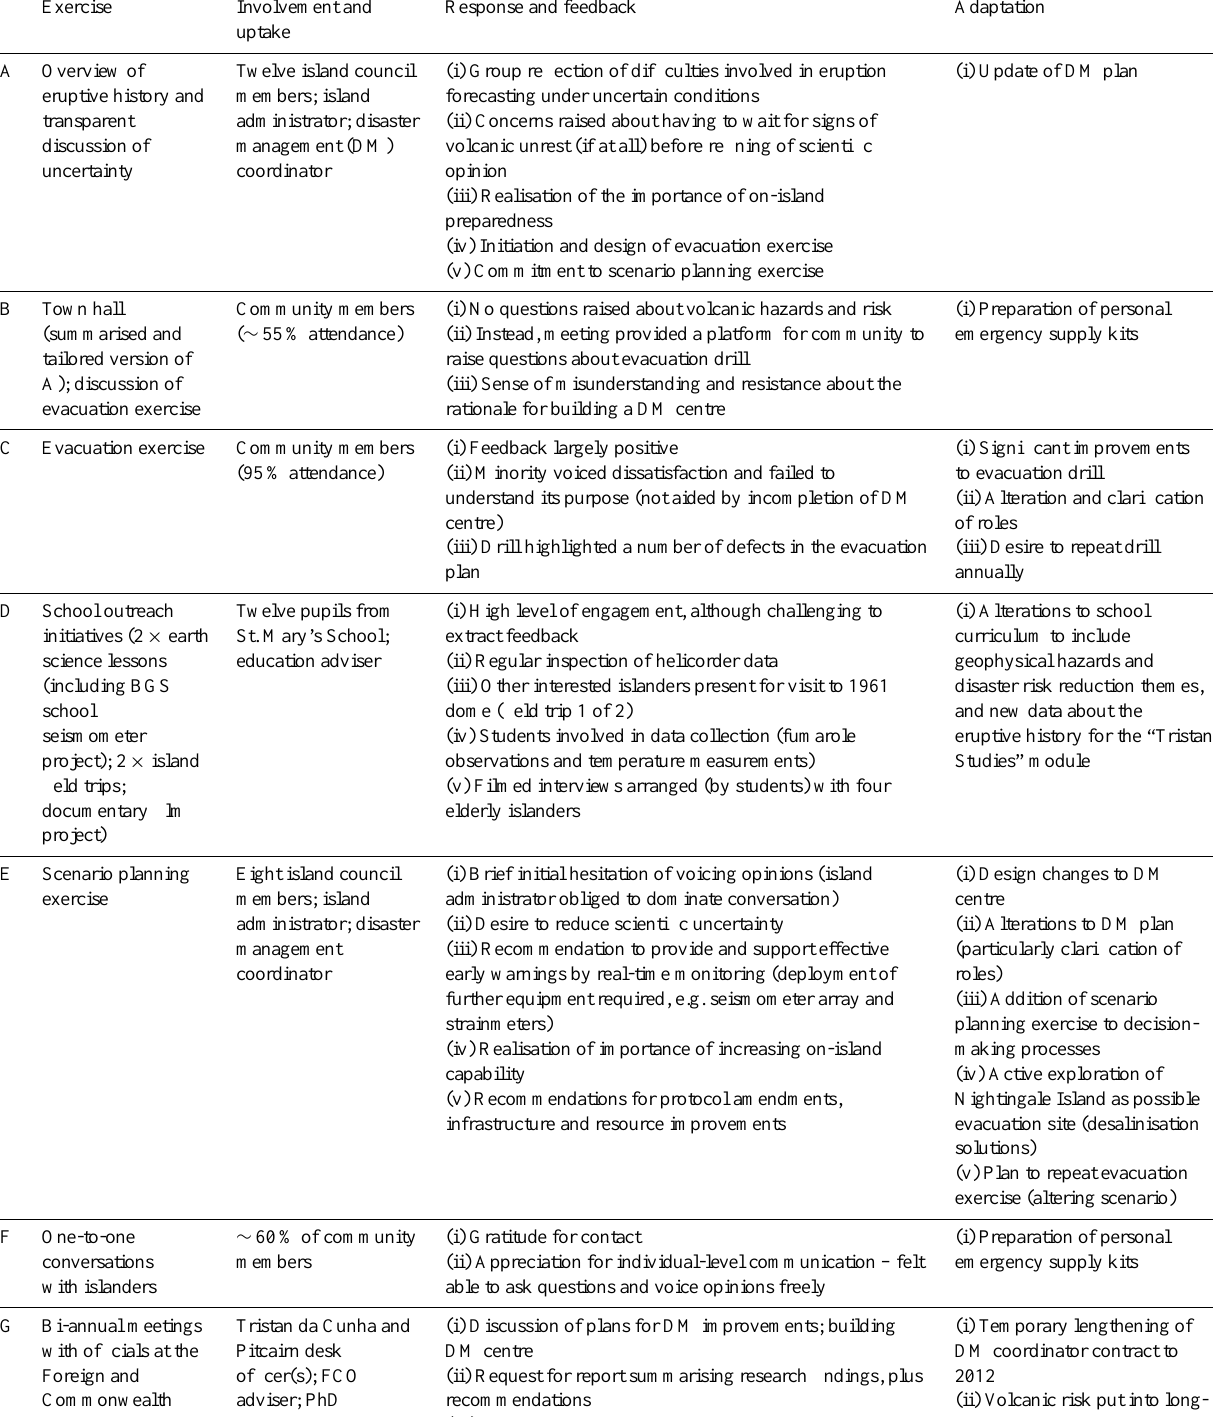
Table 3. Description and evaluation of communication strategies employed on Tristan da Cunha.